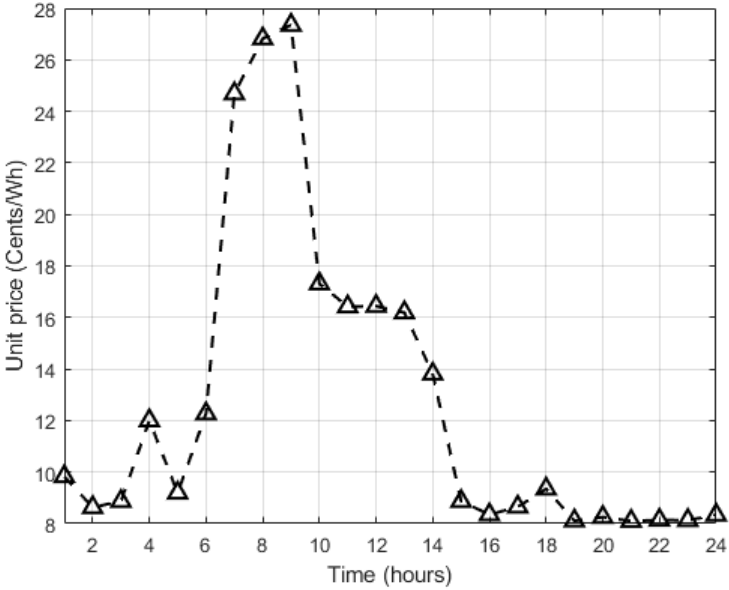
Figure 4. Pricing signal for energy